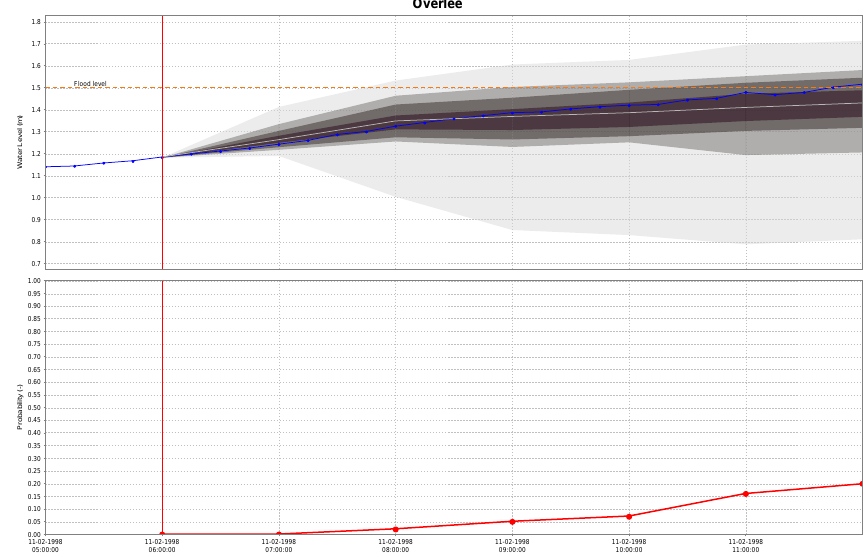
Fig. 3. Sample probability forecast as produced by the research version of the forecast production system FEWS Scotland. Two graphs are shown: a discretised predictive probability distribution of water levels at quantiles τ ∈ (.01, .05, .10, .25, .50, .75, .90,.95, .99) (top panel) and the probability of exceedence of the flooding threshold (bottom panel). In both graphs, the vertical red line indicates the forecast issue time ( t 0 ). In this case, it was forecast that there was a 20% probability of threshold exceedence at t 0 +6h . The posterior water level observation (dotted blue line) showed that the threshold was exceeded at this